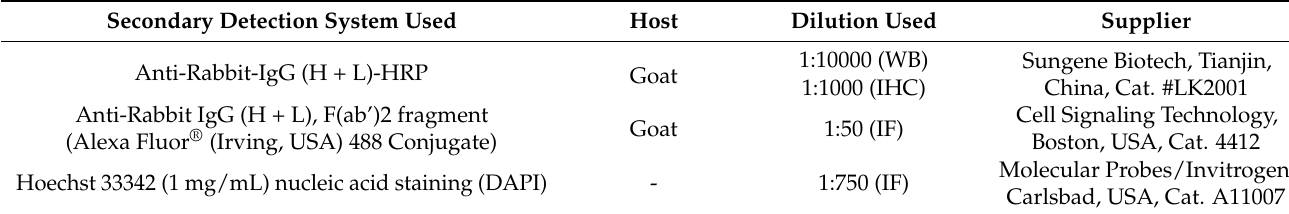
Table 6. List of secondary antibodies used for Western